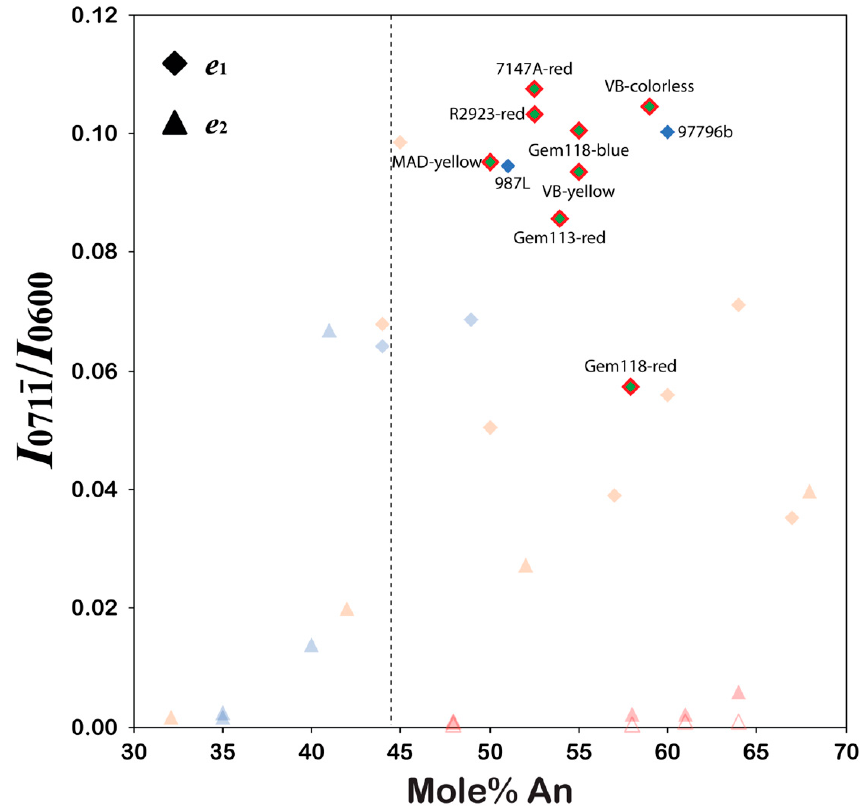
Figure 8. The normalized (0711) intensities of the samples studied in this paper along with the data from [23], plotted against An# of the samples. One obvious outlier is the red Gem118 sample, which has much weaker satellite peaks compared to the other samples, especially the blue Gem118, with which it shares the same thermal history.